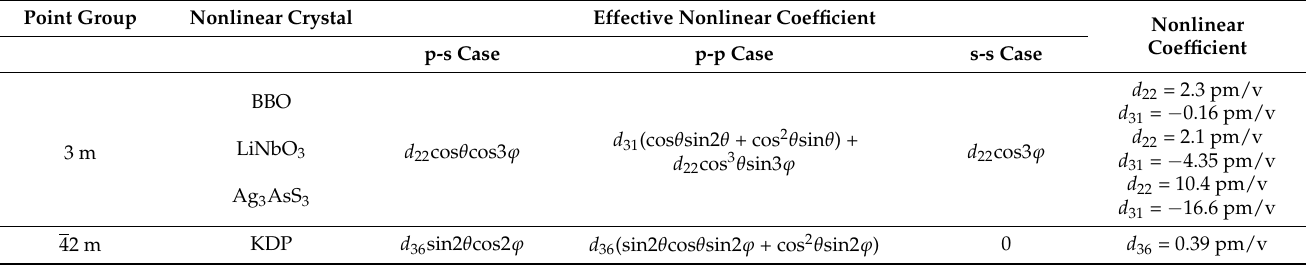
Table 2. The effective nonlinear coefficients d eff of the investigated nonlinear